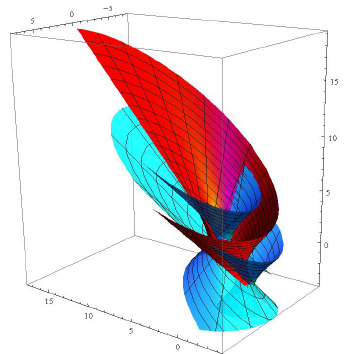
Figure 6. The red (blue) surface is the null scroll with generalized T ( B ) -lightlike ruling X 1 ( X 2 )